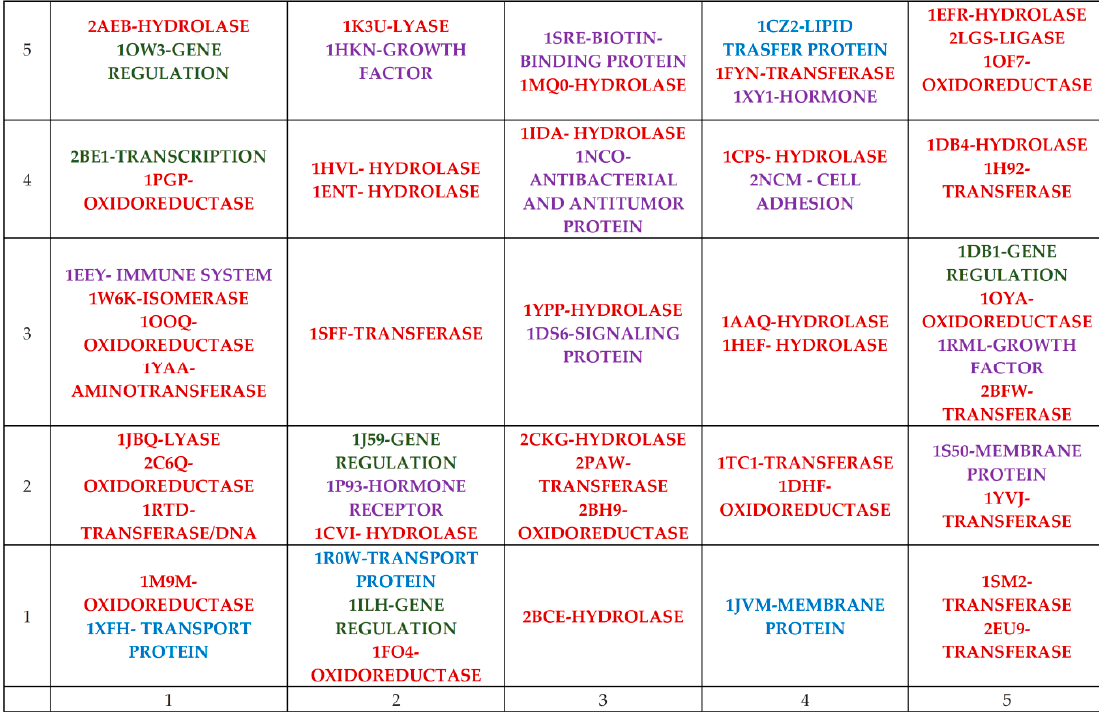
Table 2. The correlation between Average sum, Average 110, Average 57, polarizability ( QPpolrz ), and topological diameter ( TD )